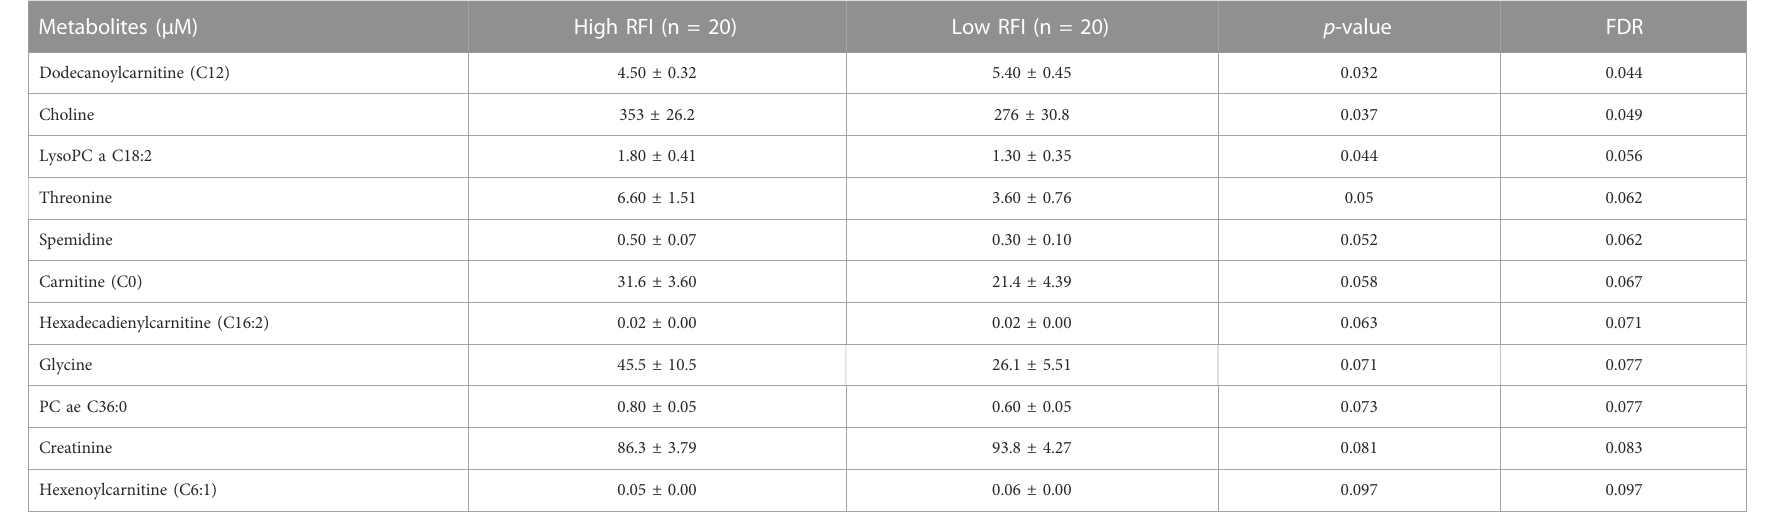
TABLE 4 ( Continued ) List of milk metabolites with altered concentrations in the high vs. low RFI comparisons at late lactation stage. The metabolite concentrations were described in least square means (LSM) and corresponding standard error of mean (SEM) in each group with p -values and false discovery rate